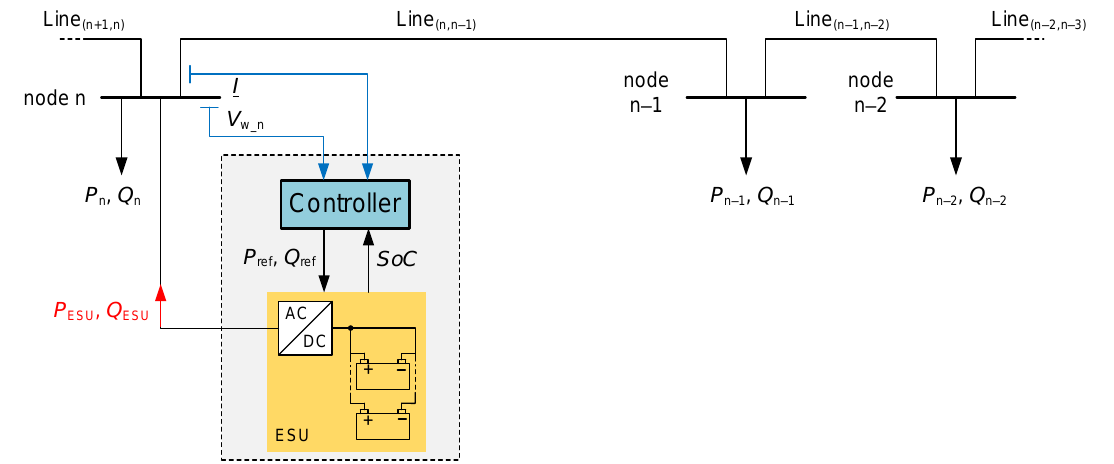
Figure 2. The schematic diagram of the proposed energy storage control system.